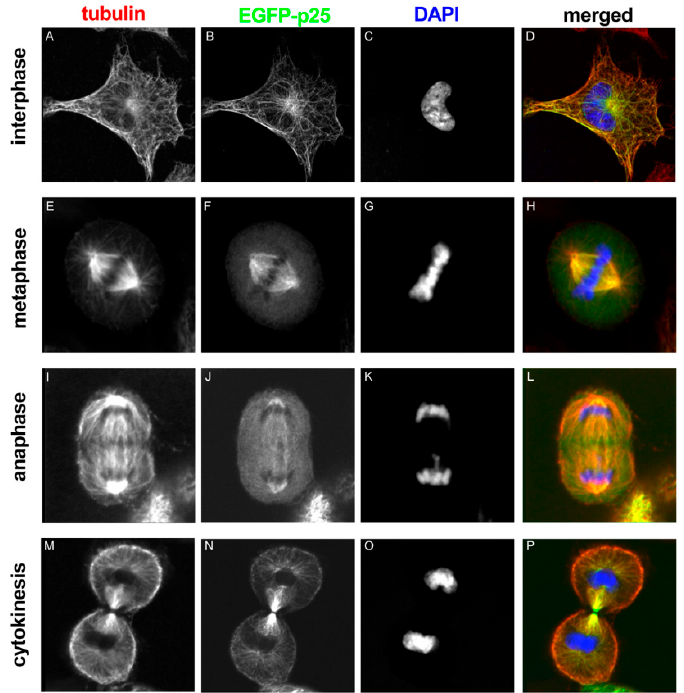
Figure 3. EGFP-TPPP/p25 localization in transfected NRK cells at different stages of mitosis. Tubulin, TPPP/p25 and DNA are red, green and blue in the merged images, respectively